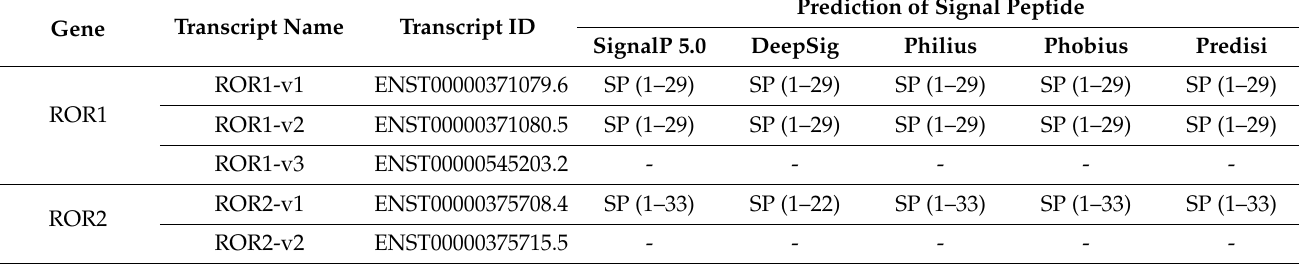
Table 2. Signal peptide prediction of ROR1 and ROR2 protein-coding transcript variants. Amino acid residues predicted by the SP prediction software SignalP 5.0, DeepSig, Philius, Phobius and Predisi as SPs are indicated within the